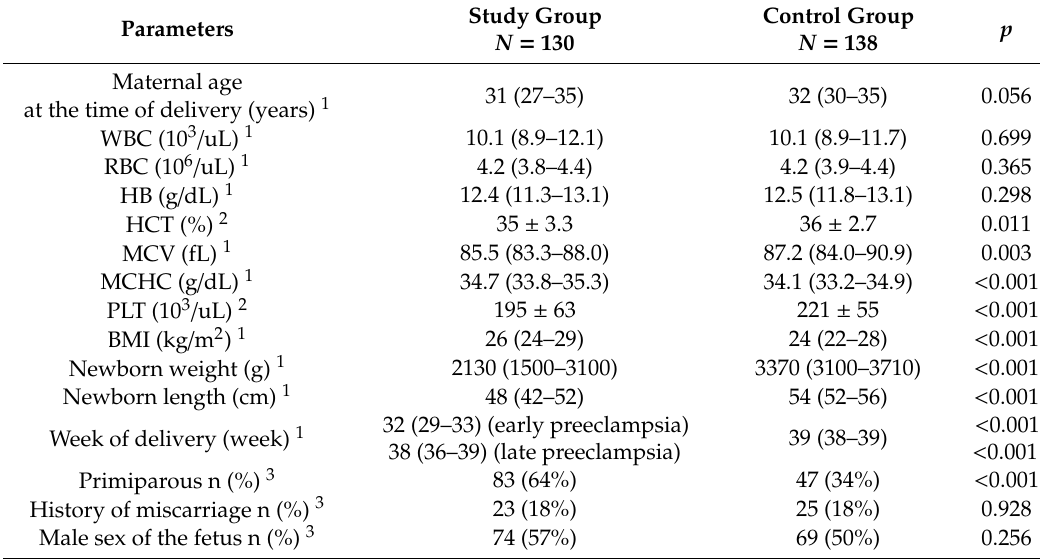
Table 1. Clinical parameters of mother and their children enrolled in the